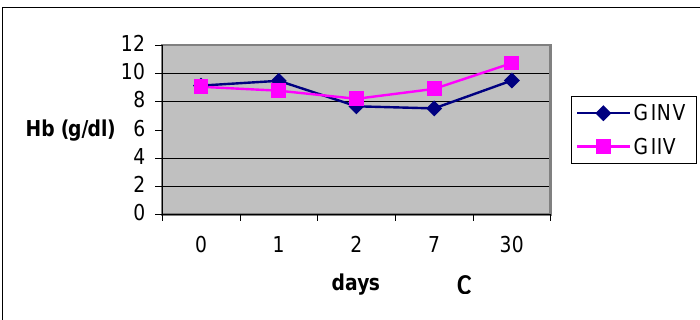
Figure 3. Red blood cell measurements (A: erythrocytes, B: globular volume, C: hemoglobin) in total blood of animals of the group inoculated with natural venom (GINV) and the group inoculated with irradiated venom (GIIV) before and after venom